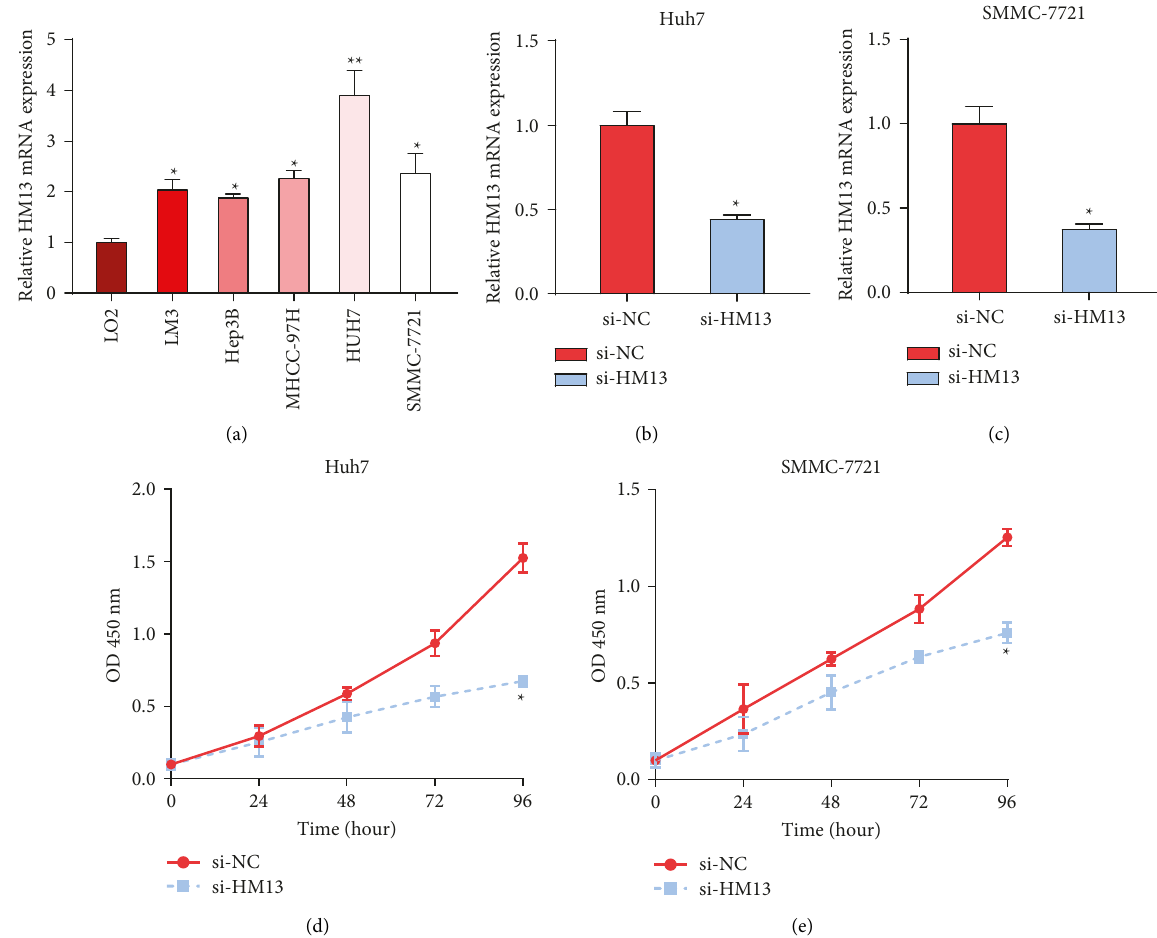
Figure 5: Assessment of reduced HM13 on LIHC cell proliferation. (a) qRT-PCR analysis of HM13 expression in LIHC cell lines and normal cells LO2 ( ∗ P < 0 . 05; ∗∗ P < 0 . 01). (b–c) To measure HM13 expression in HUh7 cells and SMMC-7721 cells by si-HM13 ( ∗ P < 0 .